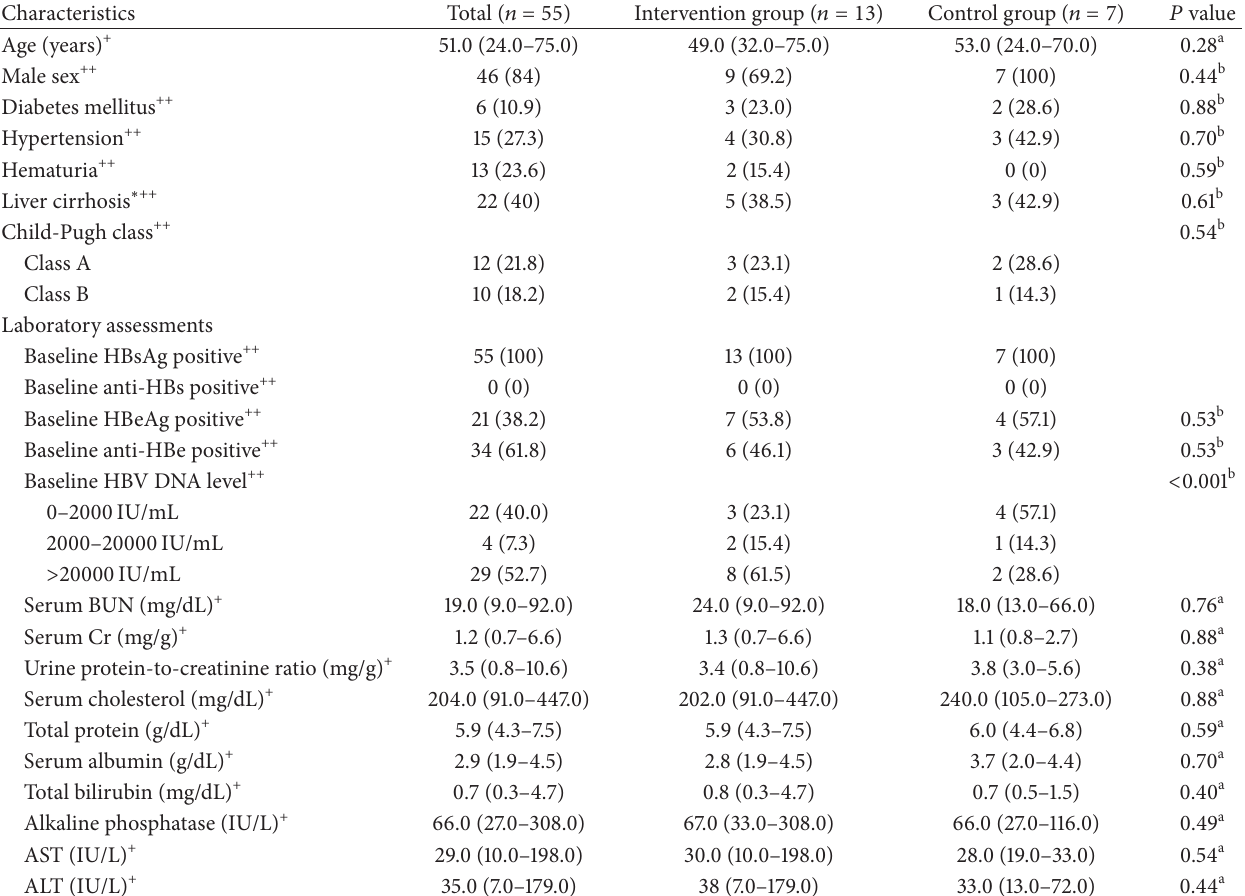
Table 1: Baseline characteristics of total patients ( 𝑛 = 55 ) and HBV-GN patients ( 𝑛 = 20 ) categorized by antiviral treatment subgroups. Characteristics